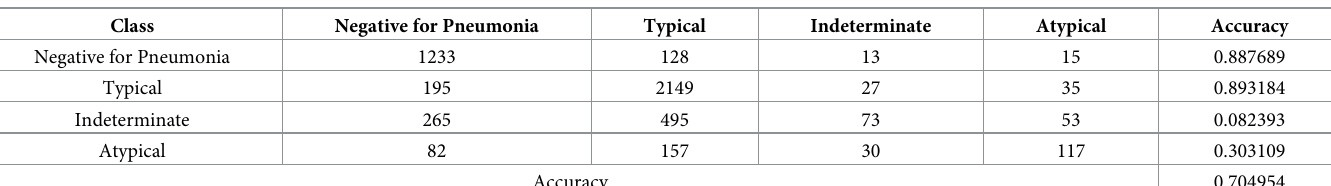
Table 4. Combined confusion